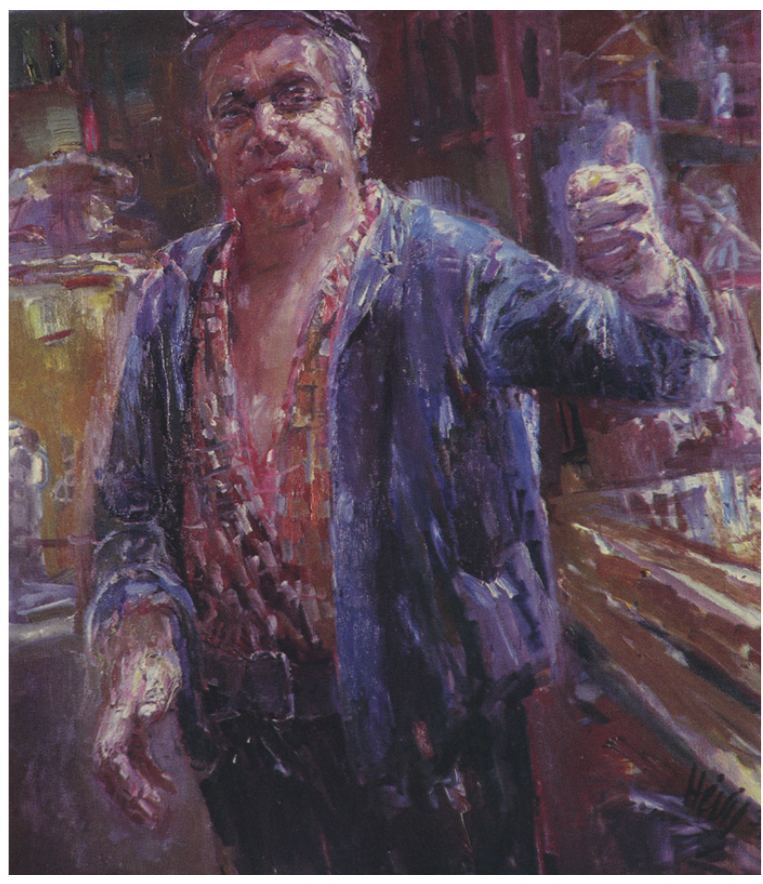
Bernhard Heisig, The Brigadier II , 1969/70. Oil on Canvas. 140 x 125 cm. (The painting no longer exists in this form; Heisig reworked it in the mid